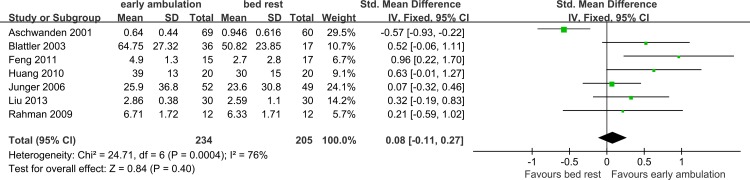
Meta-analysis of VAS change.In this figure, the data in “Mean” and “SD” column is the mean change of VAS rather than initial mean VAS.